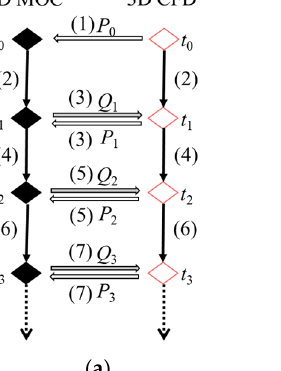
Figure 5. Coupling interface data transfer mechanism. ( a ) Turbine inlet coupling interface. ( b ) Tur- bine outlet coupling interface.